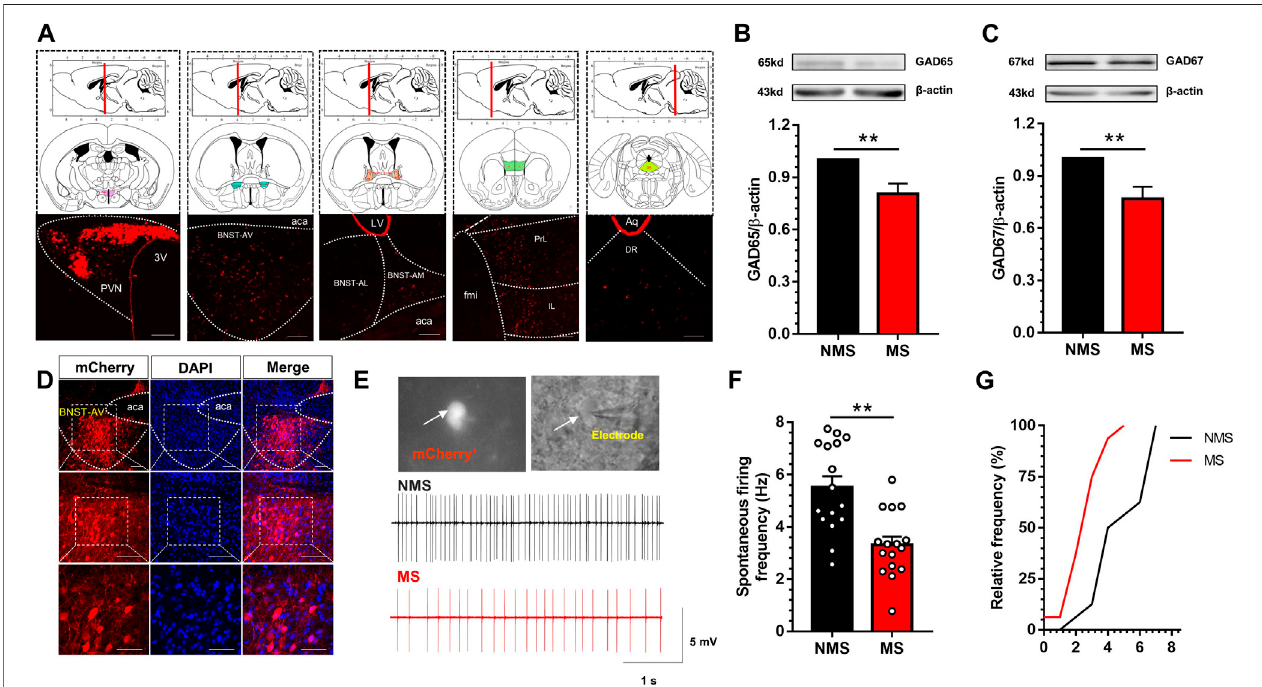
FIGURE3| ExcitationofGABAneuronsinBNST-AVregionwasdecreasedinmicewithMS-inducedchronicvisceralpain (A) LumawasabsorbedbyPVNneurons anddirectlytransmittedtomPFC,BNST-AV,BNST-AL,BNST-AMandDR(3V,thirdventricle;fmi,forcepsminorofcorpuscallosum;PrL:prelimbiccortex;IL:infralimbic cortex; aca, anterior limb of ac; LV, lateral ventricle; Aq, mesencephalic aqueduct; DR: dorsal raphe nucleus). scale bar (cid:2) 100 μ m (B – C) Western blot analysis of GAD65 and GAD67 protein in the BNST-AV demonstrated that MS mice presented signi fi cant decrease in the expression of GAD65 protein (B, n (cid:2) 6; ** p < 0.01) and GAD67(D, n (cid:2) 6;** p < 0.01)comparedwithNMSgroup (D) ThelocalizationofGABAergicBNST AV -PVNneuronsviaPVN-injectedretrograde rAAV-Ef1 α -DIO-mCherry- WPRE-pAinVgat-Cremice.Scalebar (cid:2) 100 μ mexceptforthebottommarkedby50 μ m (E) Theschemaofspontaneous fi ringfrequencyinGABAergicneuronsinBNST- AV regions (F) The spontaneous fi ring frequency of GABA neurons (mCherry+) in MS group was signi fi cantly decreased vs. NMS group ( n (cid:2) 16, six mice per group; ** p < 0.01) (G) The cumulative frequency distribution curves in MS groups were evidently shifted leftward.